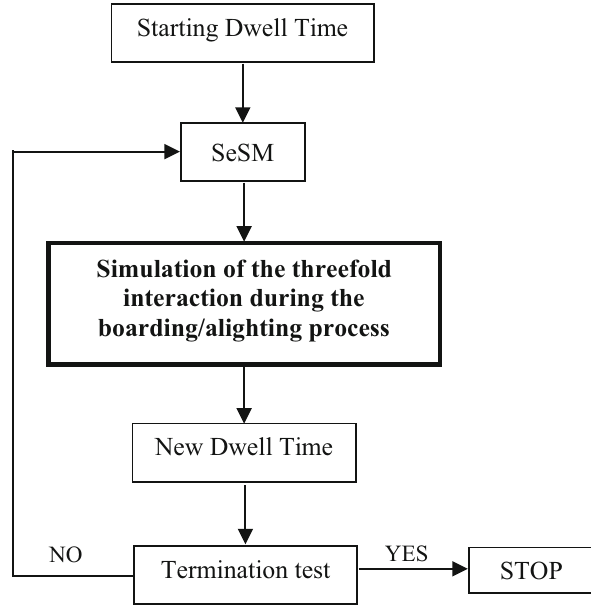
Fig. 6 Graphic representation of the iterative